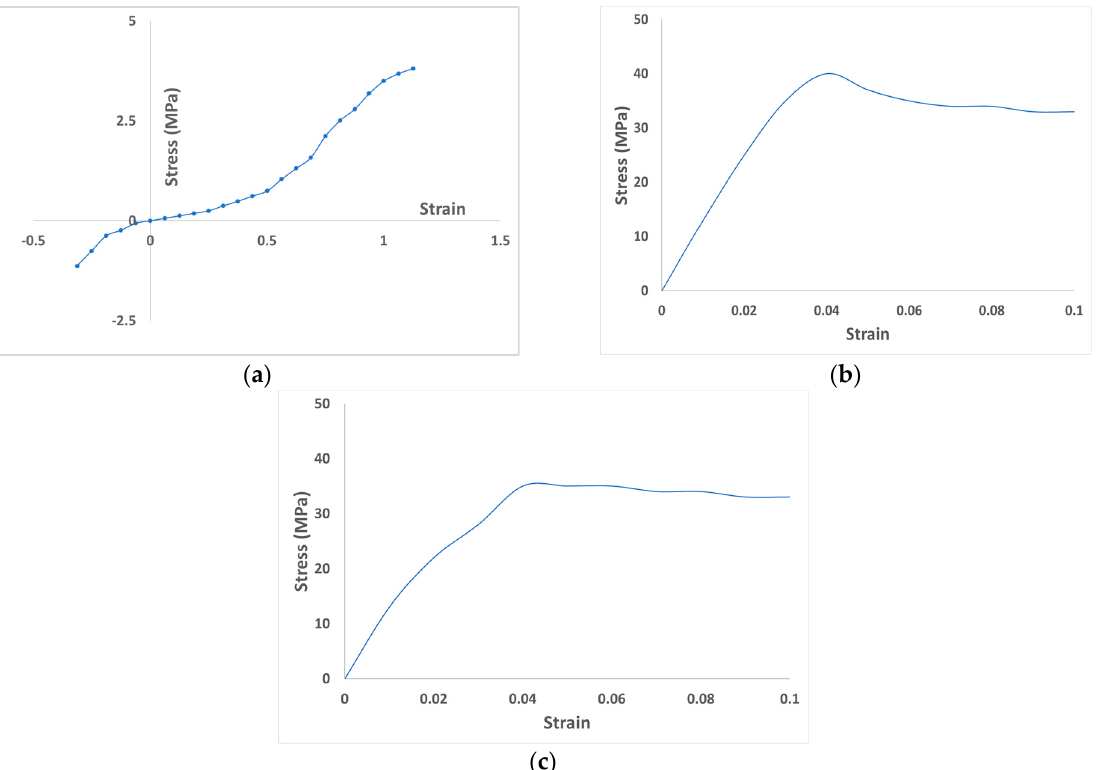
Figure 2. Stress–strain curve for nonlinear material properties of ( a ) PDL, ( b ) 0.5 mm-thick aligner, and ( c ) 0.75 mm-thick aligner.